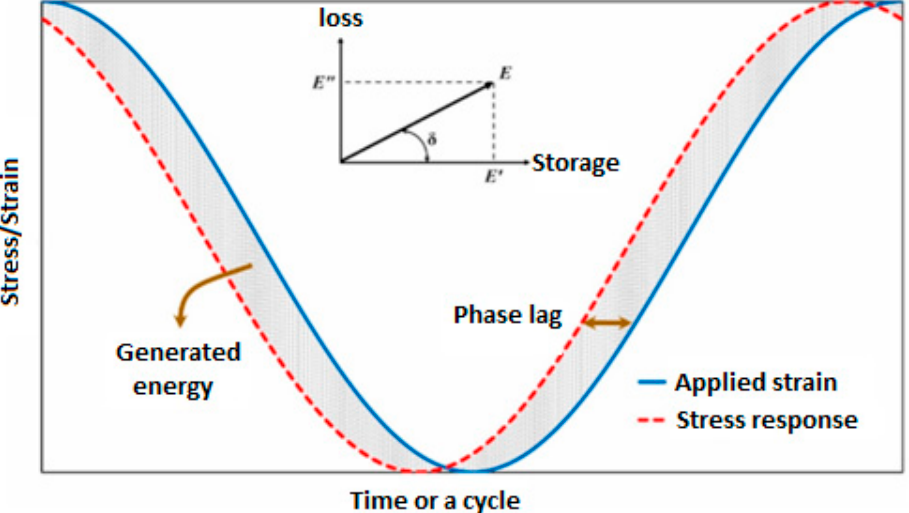
Figure 12. Schematic demonstration of the generated thermal energy for a polymer-based structure due to phase lag between stress and strain over an entire cycle, adapted with permission from Ref. [49]. Copyright © 2021 Elsevier